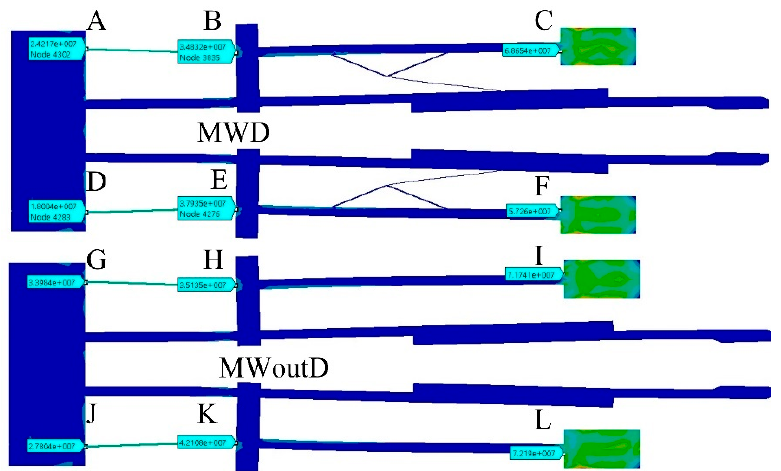
Table 10. Comparison of performance parameters of microgripper, obtained by simulation in ANSYS.